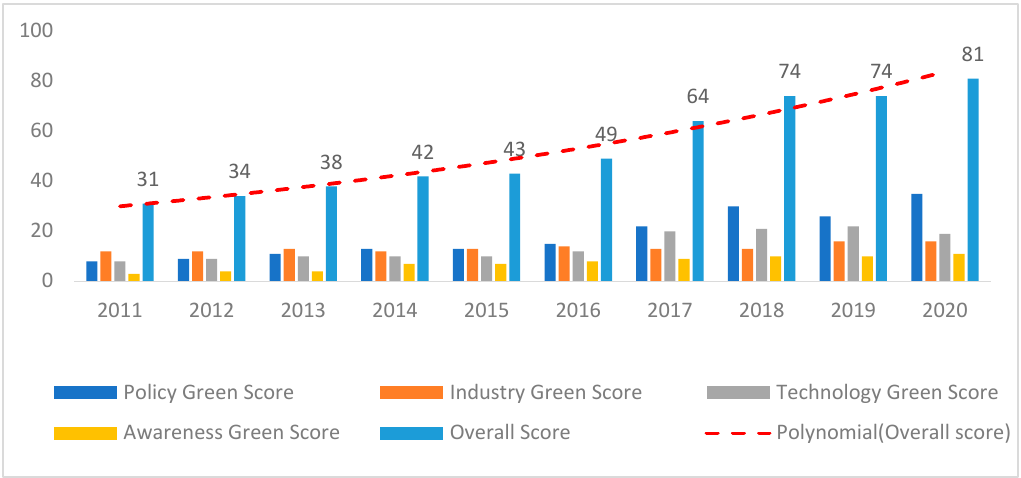
Figure 2. Overall agricultural green development in Yantai in Yantai from 2011 to 2020.